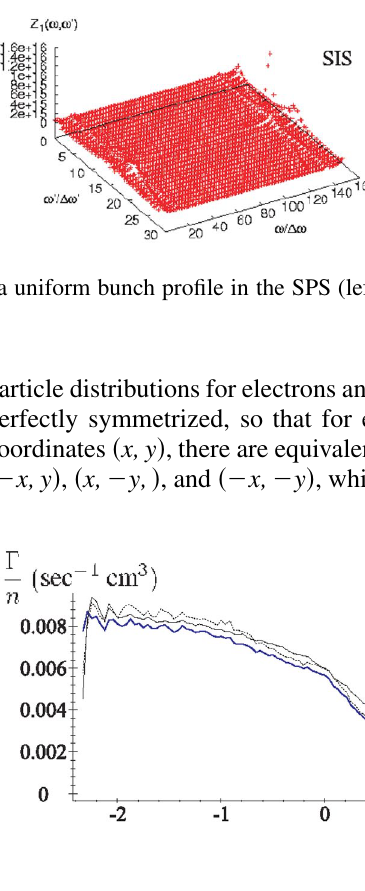
FIG. 77. (Color) Emittance growth rate as a function of longi- tudinal position within the bunch for three different electron densities, in the absence of synchrotron motion. The beam center ; the arrow shows the ‘‘arrival-point corresponds to (cid:12) (cid:3) (cid:12) 0 location,’’ which is the point where electrons starting at small amplitudes first and simultaneously cross the beam axis